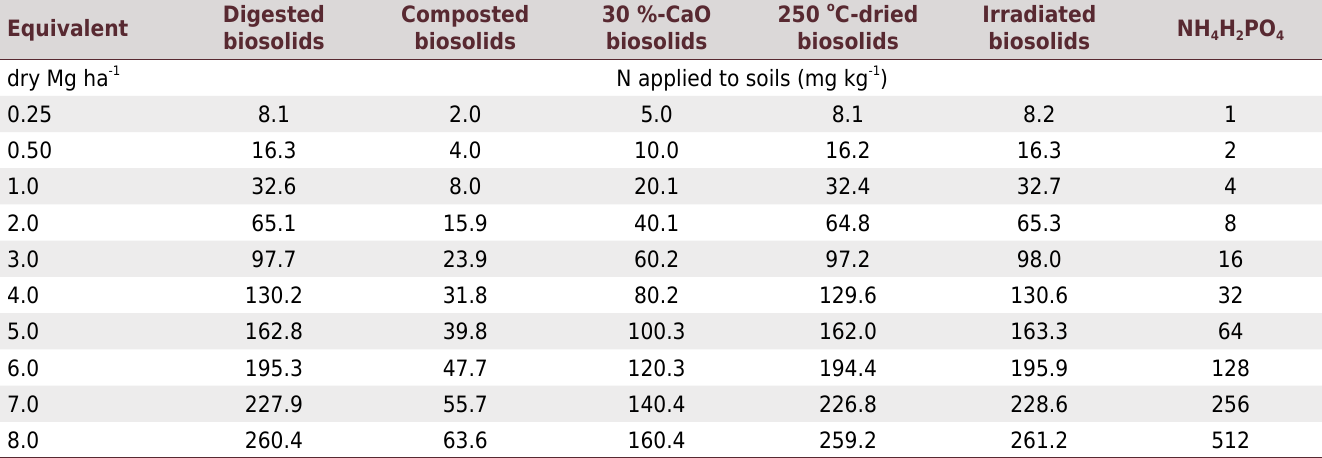
Digested Composted biosolids biosolids